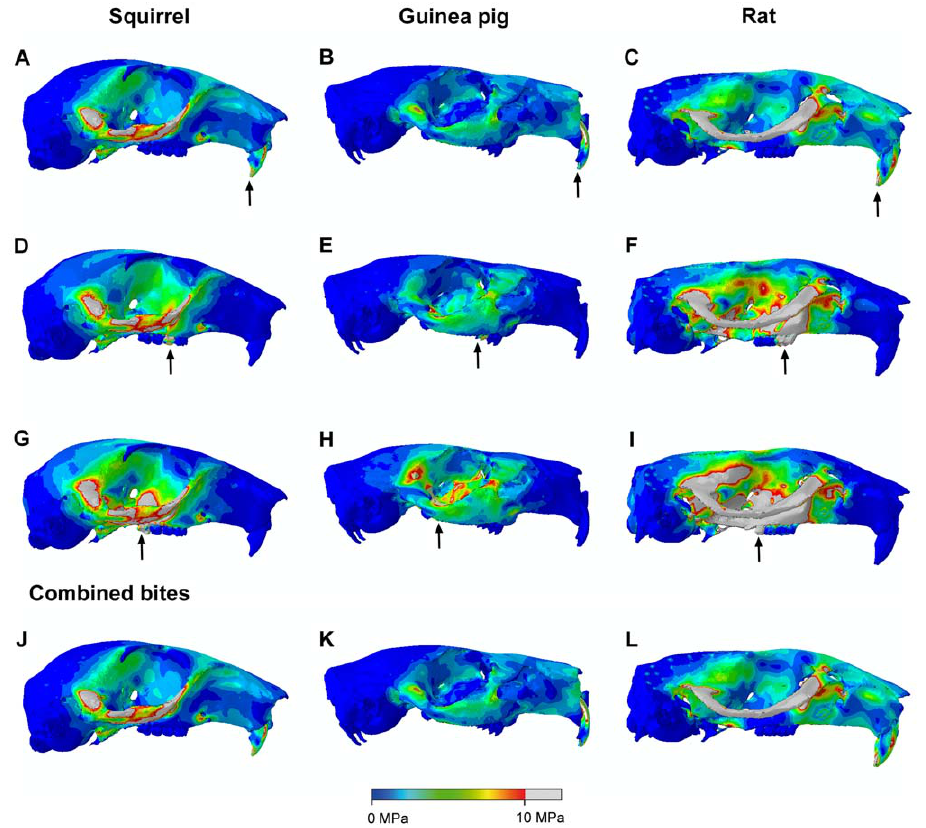
Figure 3. Predicted distribution of von Mises stresses across the skull. Arrows indicate the biting tooth: (A–C) incisor bites; (D–F) unilateral bites on M1; (G–I) unilateral bites on M3; (J–L) maximum von Mises stress experienced by each element across unilateral and bilateral bites on every tooth. (A,D,G,J) squirrel; (B,E,H,K) guinea pig; and (C,F,I,L) rat. Grey areas indicate von Mises stresses exceeding 10 MPa.